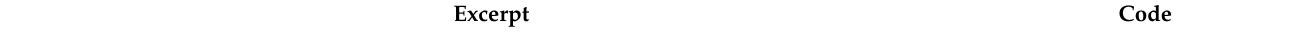
Table 4. Selected excerpts on the topic of economic arguments in favour of change in the LOMCE. Excerpt